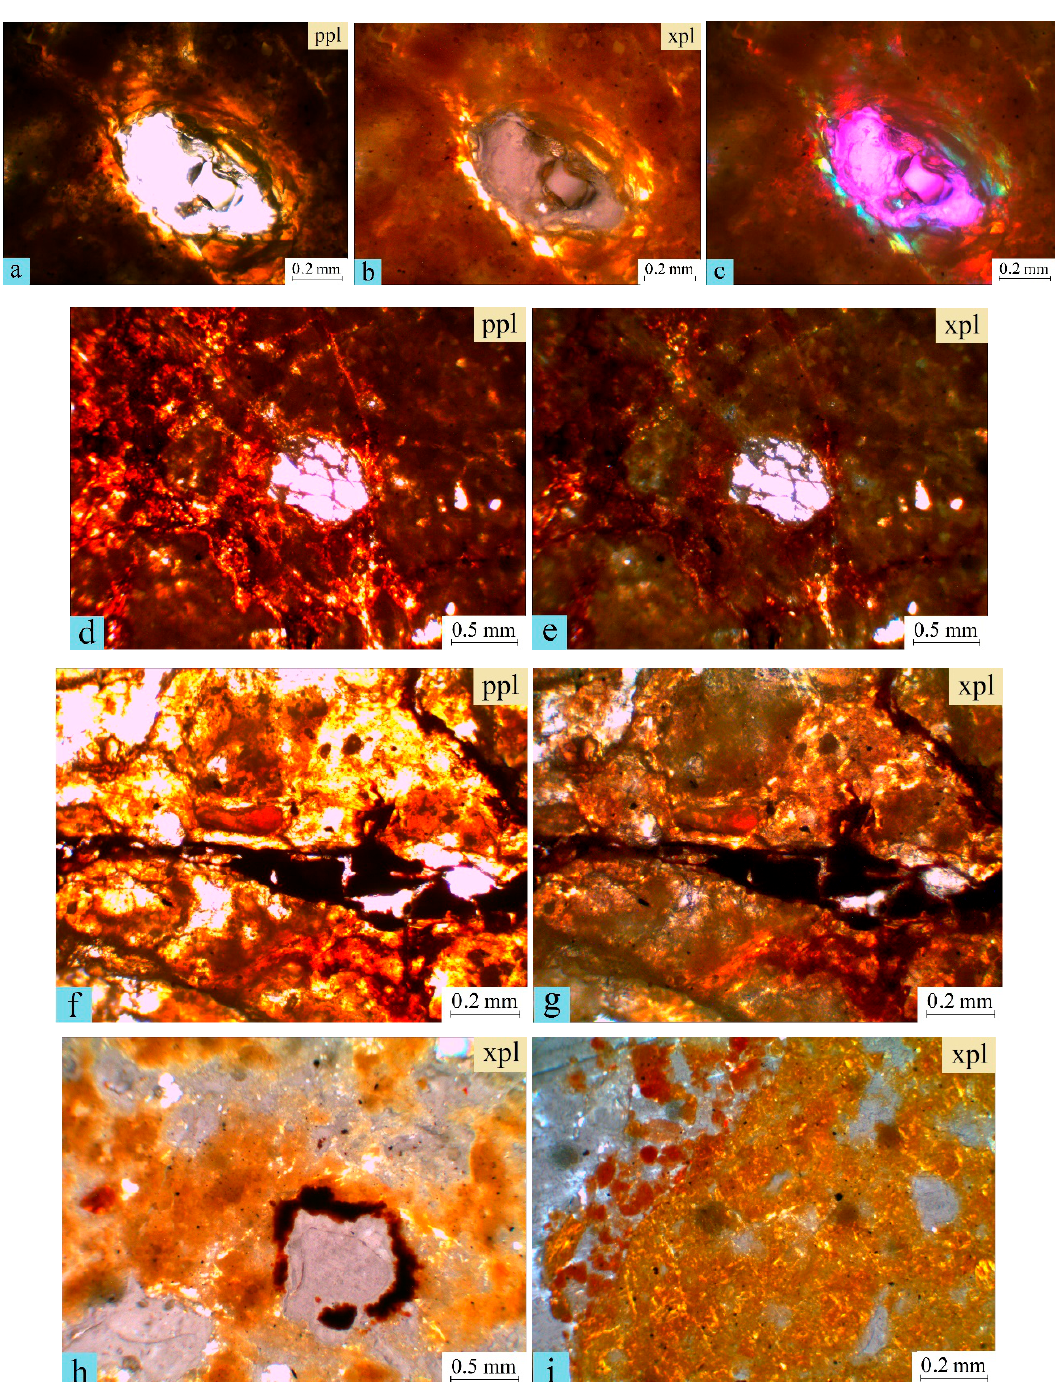
Figure 5. Pedological features in the white–yellow mottling: ( a , b ) laminated clay coating along pore wall, with gypsum plate ( c ) showing concentric deposition; ( d , e ) clear, jointed quartz crystal showing crystalline continuity and absence of clay impregnation; ( f , g ) Mn oxide coating along planar and channel; ( h ) voids of preferential water flow; ( i ) loose discontinuous infilling of redder, spherical granules on faunal channel. Note different types of b -fabrics. ppl: plane polarized light; xpl—cross-polarized light.